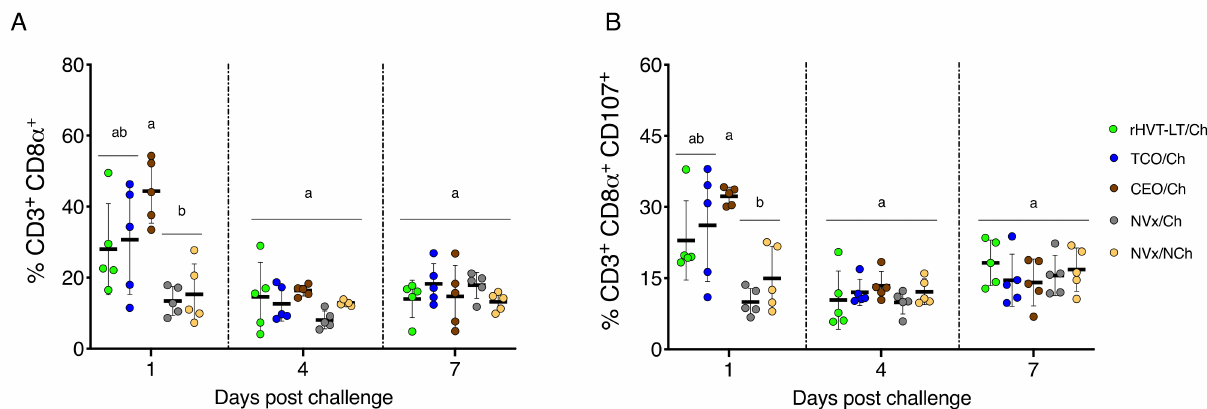
Figure 2. Vaccines induce protection against an ILTV challenge: ( A ) clinical signs score at 4 dpch; ( B ) survival percentage from 1 to 7 dpch; ( C ) histopathology lesions score in the trachea at 4 dpch; ( D ) ILTV viral load in the trachea at 1, 4 and 7 dpch. Bar graphs and small horizontal lines indicate the mean ( ± SD). Each dot represents an individual chicken. Different letters indicate significant differences ( p < 0.05).